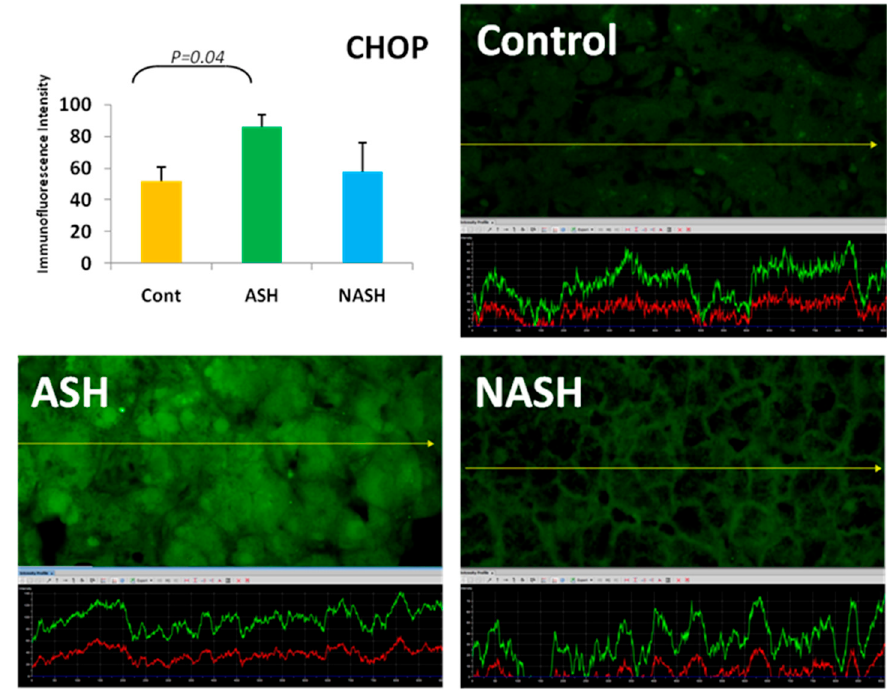
Figure 4. The expression of CHOP (CCAAT/enhancer-binding protein homologous protein) in ASH was significantly increased in ASH compared with controls ( p < 0.05) and was increased compared to NASH. Its expression in NASH was increased in comparison to controls. Previously published in [21].